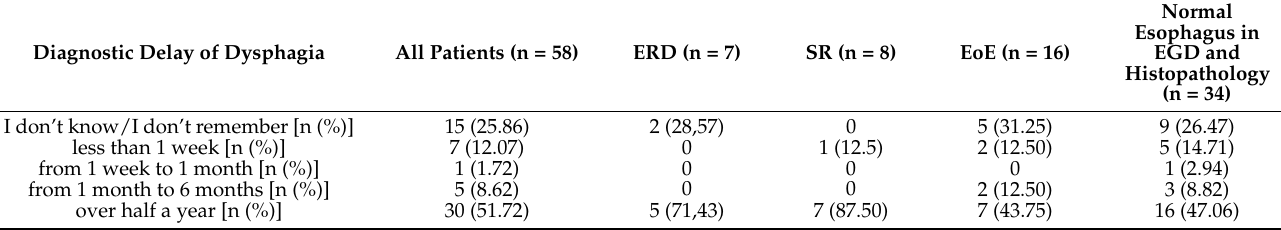
Table 3. Diagnostic delay of dysphagia patients with ERD, SR, EoE, normal esophagus in EGD and histopathology